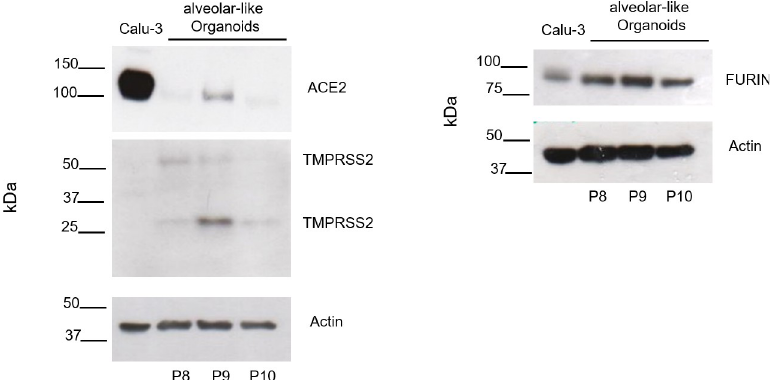
Fig 1. Analysis of SARS-CoV-2 host factor expression by Western blot. Representative Western blots for ACE2, TMPRSS2, and FURIN of protein lysates from human alveolar-like organoids of three different donors (P8-P10). Calu- 3 cells served as positive control.